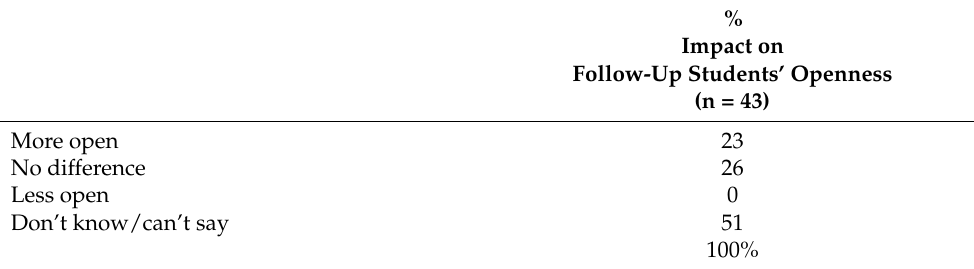
Table 4. Perceived campaign impact on follow-up students’ openness about mental health issues.